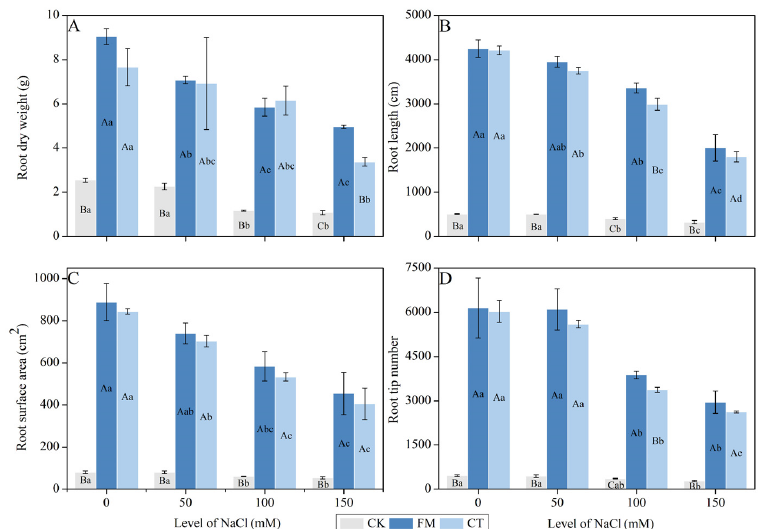
Figure 2. Variations in the root dry weight and morphologies between treatments. ( A ) root dry weight of different treatments; ( B ) root length of different treatments; ( C ) root surface area of different treatments; ( D ) root tip number of different treatments. The meanings of the letters and error bars are consistent with Figure 1.